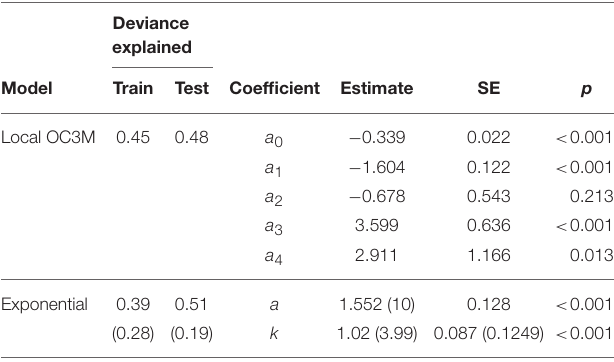
Frontiers in Marine Science |